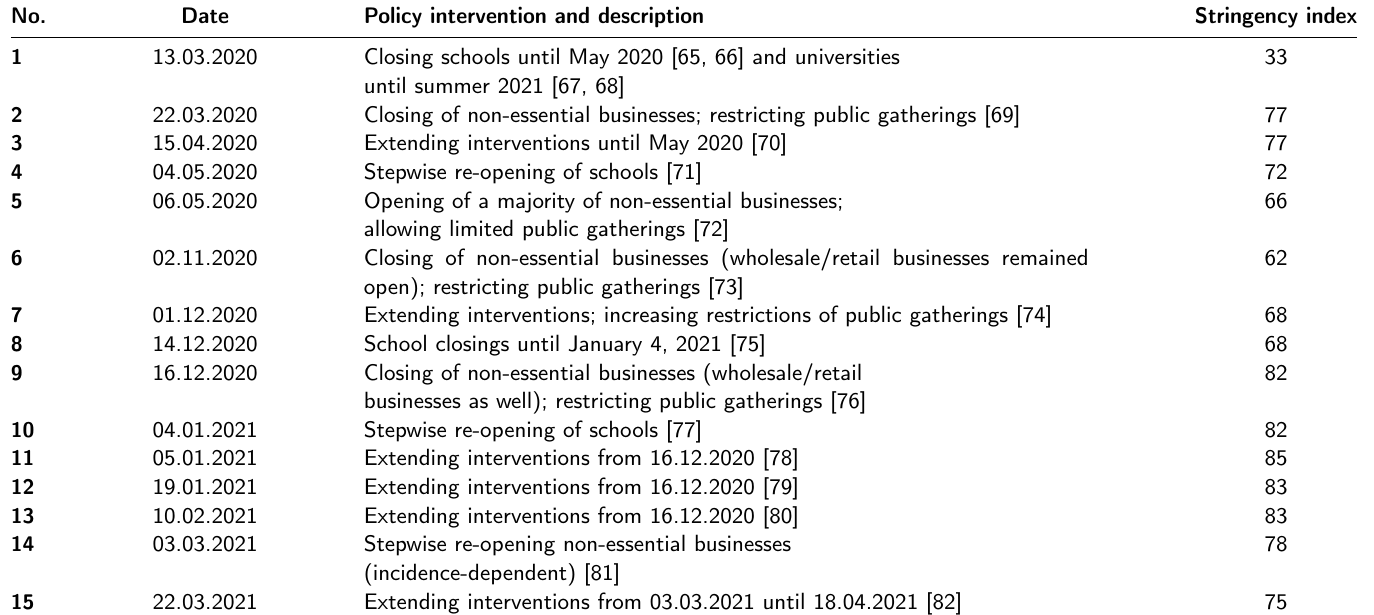
Table 1: Timeline of non-pharmaceutical policy interventions in Germany between 13 th March 2020, and 22 nd March 2021